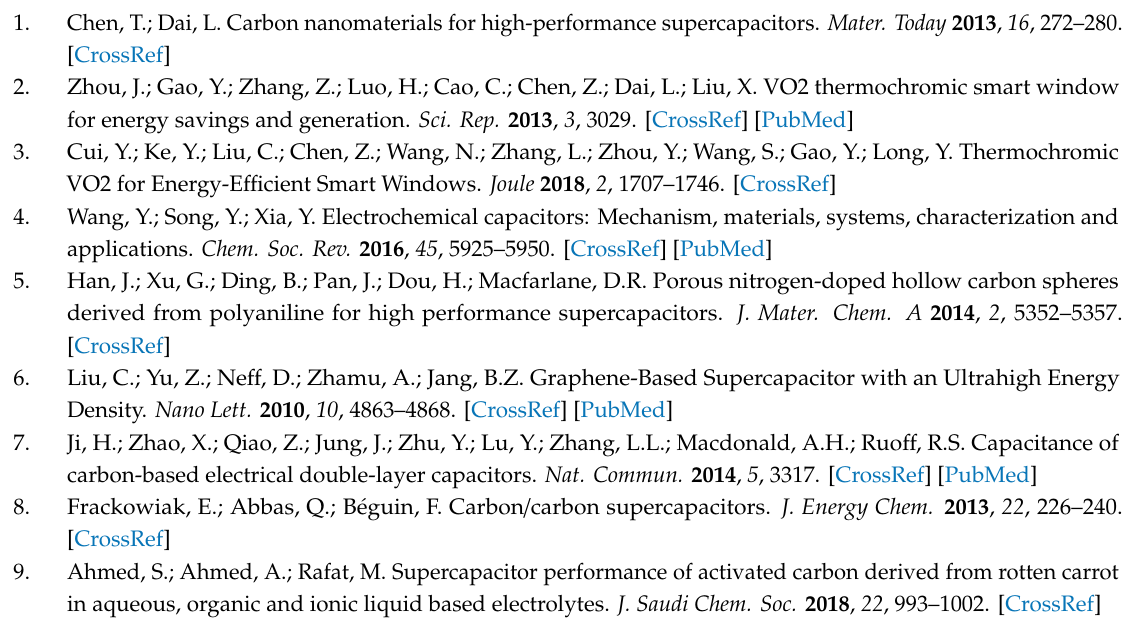
Figure S1: The fitted high-resolution XPS spectrum of C 1s for the sample of N CNFs-1, Figure S2: The electrochemical performance of N CNFs-1 in a two-electrode